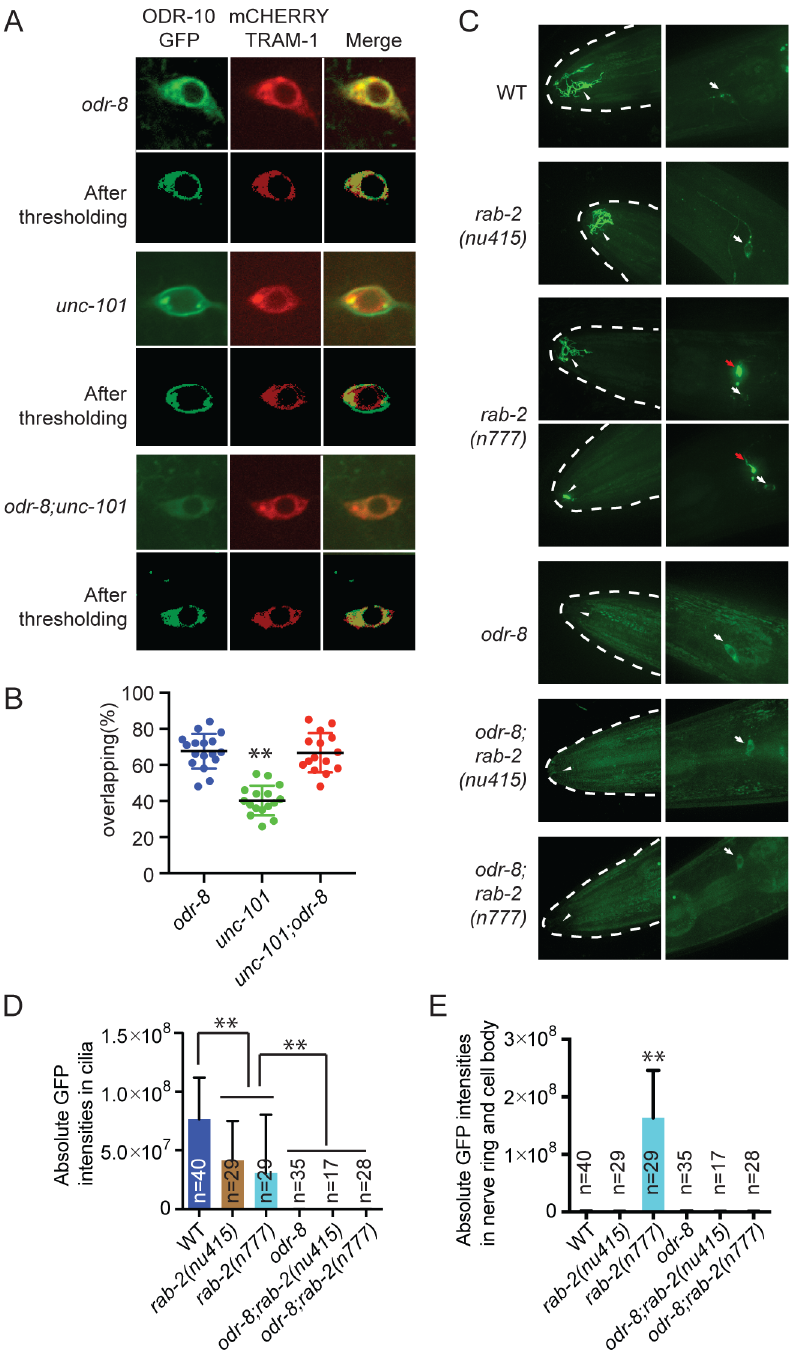
Figure 5. ODR-8 acts in an early step in ODR-10 trafficking to the AWA cilia. (A) Localization of ODR-10-GFP in AWA neurons of odr-8(ky31) , unc-101(m1) and odr-8(ky31); unc-101(m1) mutants. Thresholded images were obtained as described in the methods. (B) Quantitative analysis of ODR- 10 and TRAM-1 co-localization in AWA neurons of odr-8(ky31) , unc-101(m1) and odr-8(ky31); unc-101(m1) mutants. (C). Localization of ODR-10-GFP in AWA neurons in rab-2 mutants. Arrowheads indicate the AWA cilia, white arrows point to the AWA cell body and red arrows show the AWA processes in the nerve ring. In rab-2(n777) mutants, 23 out of 29 animals displayed normal ODR-10-GFP localization in AWA cilia, and 6 out of 29 show the ODR- 10-GFP localization defects in AWA cilia. (D–E). Quantification of ODR-10-GFP signals in the cilia (D) and axons (including cell body) (E) of AWA neurons. **, p , 0.01 (ANOVA, Bonferroni’s multiple comparisons test); for E, rab-2(n777) shows p , 0.01 compared to all other genotypes plotted.